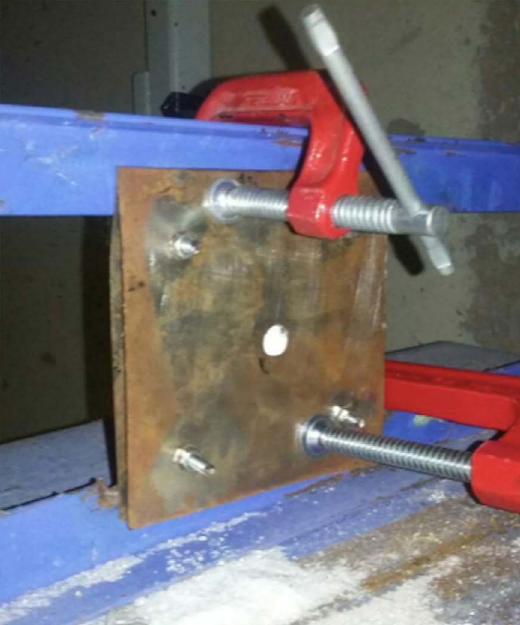
Figure 1. Fixing of samples confined by the steel plates for the ballistic